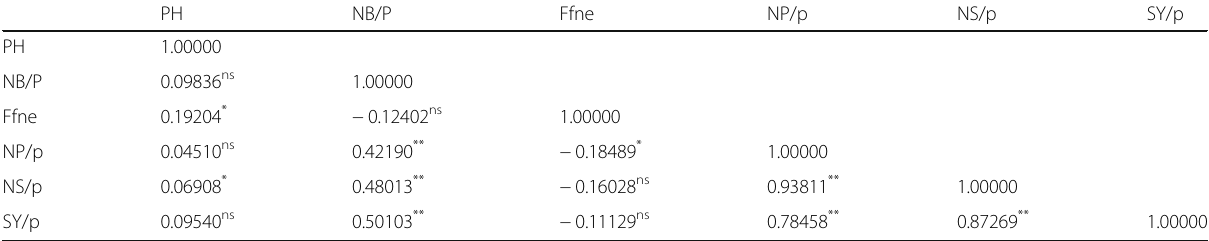
Table 4 Correlation coefficients of the calculated agronomic traits of 18 faba bean genotypes grown over two